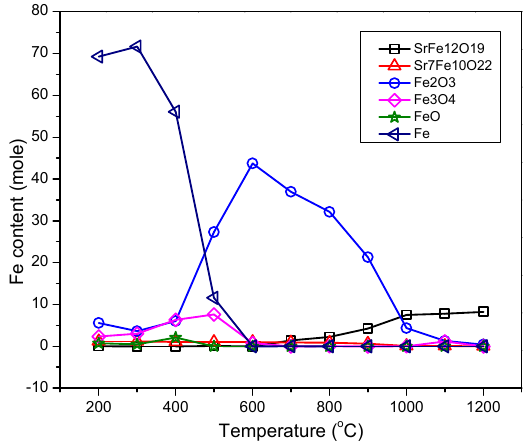
Figure 11. Fe content of different phases in the gas heat treated samples, re-calcined at different temperatures (normalized on the basis of supposing that the initial amount of Fe in the sample was 100 moles).